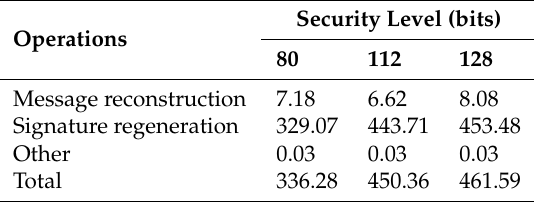
Table 9. Processing time (ms) for receiver